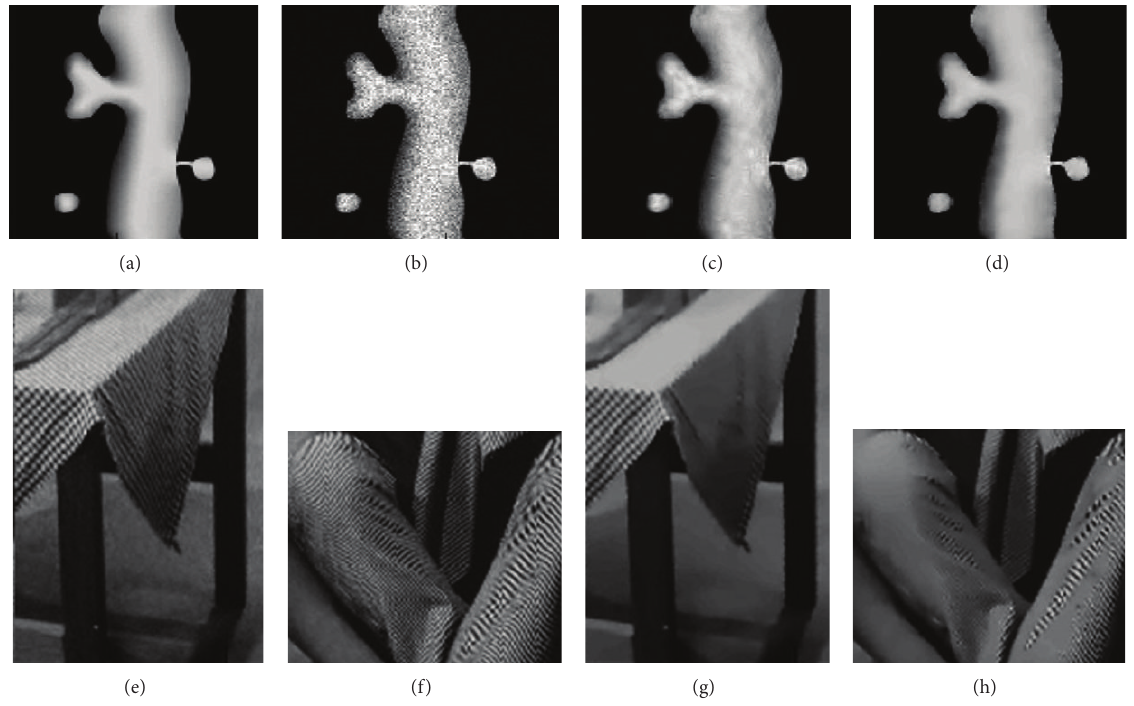
Figure 18: (a–d) show denoising results for Confocal Microscopy Phantom: from left to right: noise-free image, noisy image, and denoised image with our model and denoised image with Fast TI Haar algorithm. (e–h) show from left to right parts of denoised Barbara image with BiGaussMixShrinkL method and parts of denoised Barbara image with Fast TI Haar